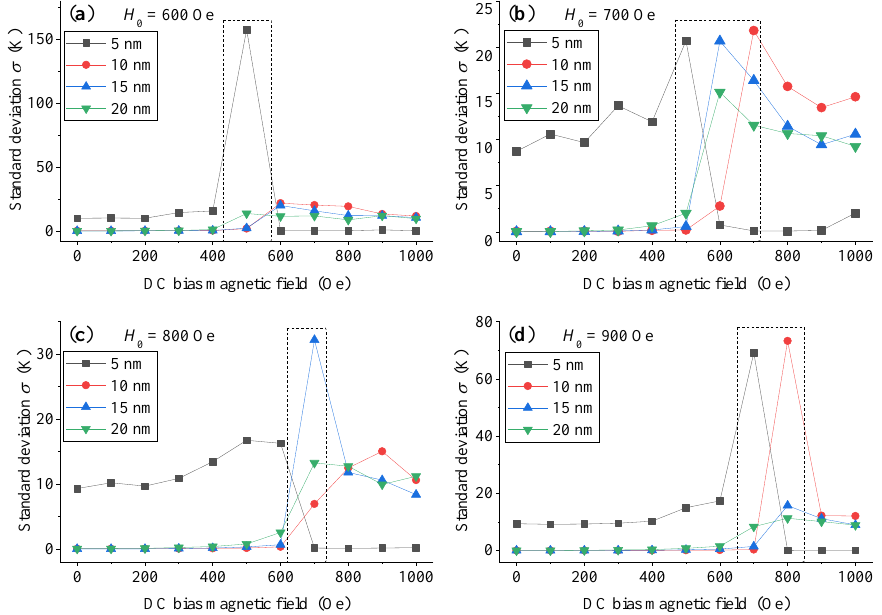
Figure 8. The standard deviation of MNPs with different particle sizes with different DC bias field H dc when the amplitude H 0 of triangular wave excitation magnetic field is ( a ) 600 Oe, ( b ) 700 Oe, ( c ) 800 Oe and ( d ) 900 Oe, respectively.